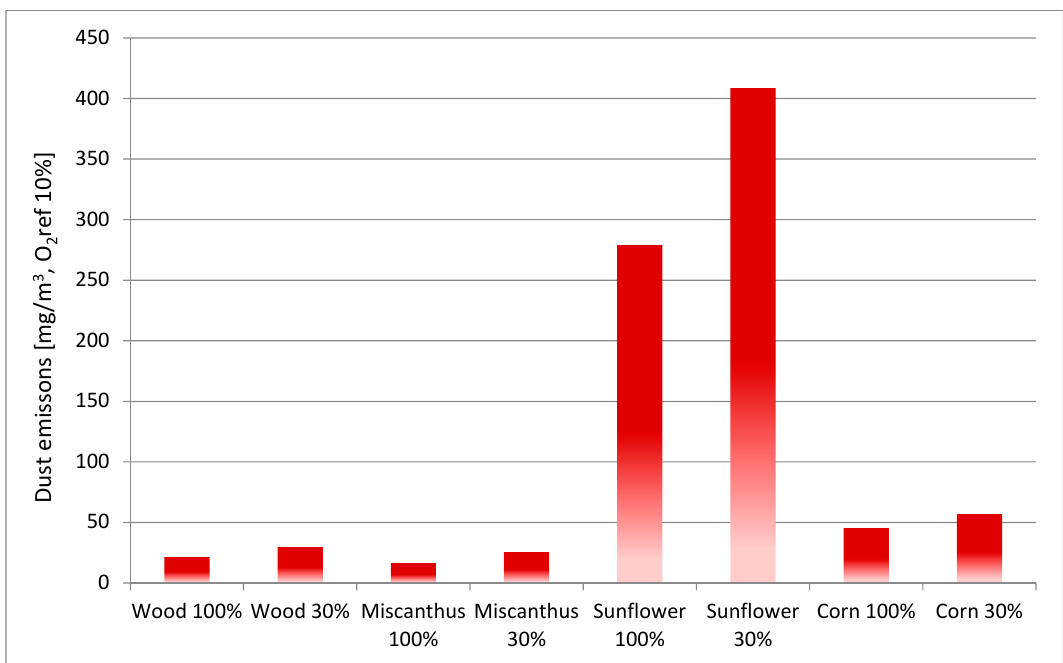
Figure 11. Comparison of dust emission from different types of pellets.